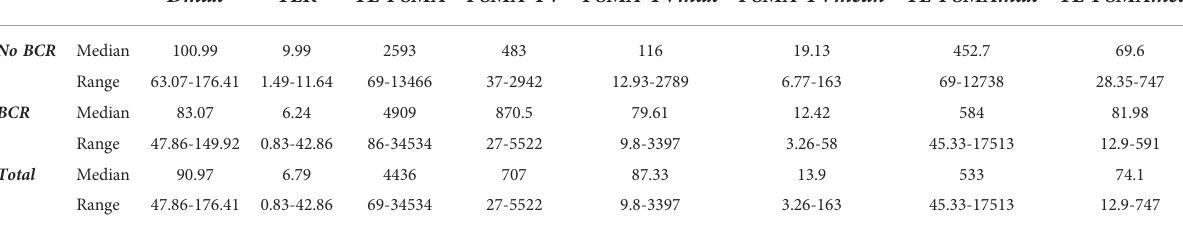
TABLE 4 The results of pre-treatment 68Ga-PSMA PET/CT derived quantitative